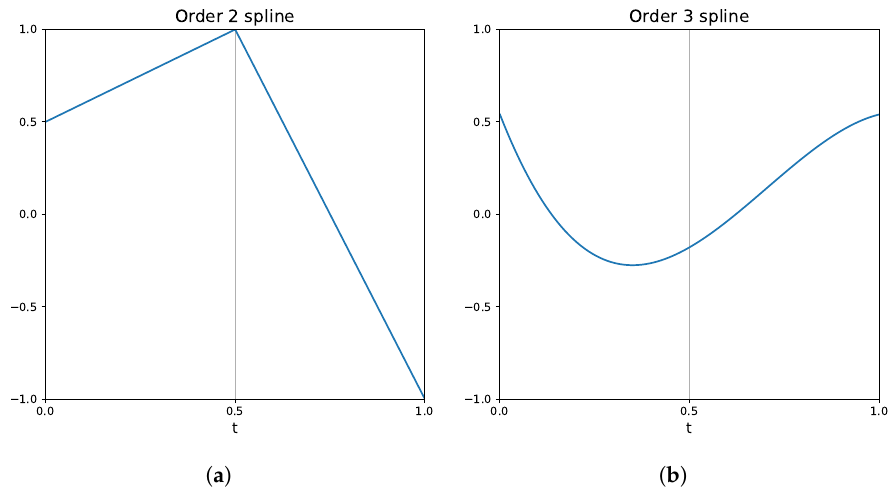
Figure 1. Sample spline functions of ( a ) second and ( b ) third orders, with limits at 0 and 1 and knots at